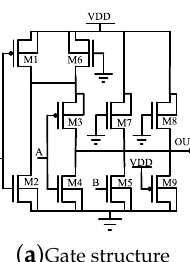
Figure 3. BSPL NAND gate, and the status of the transistors for different input values.